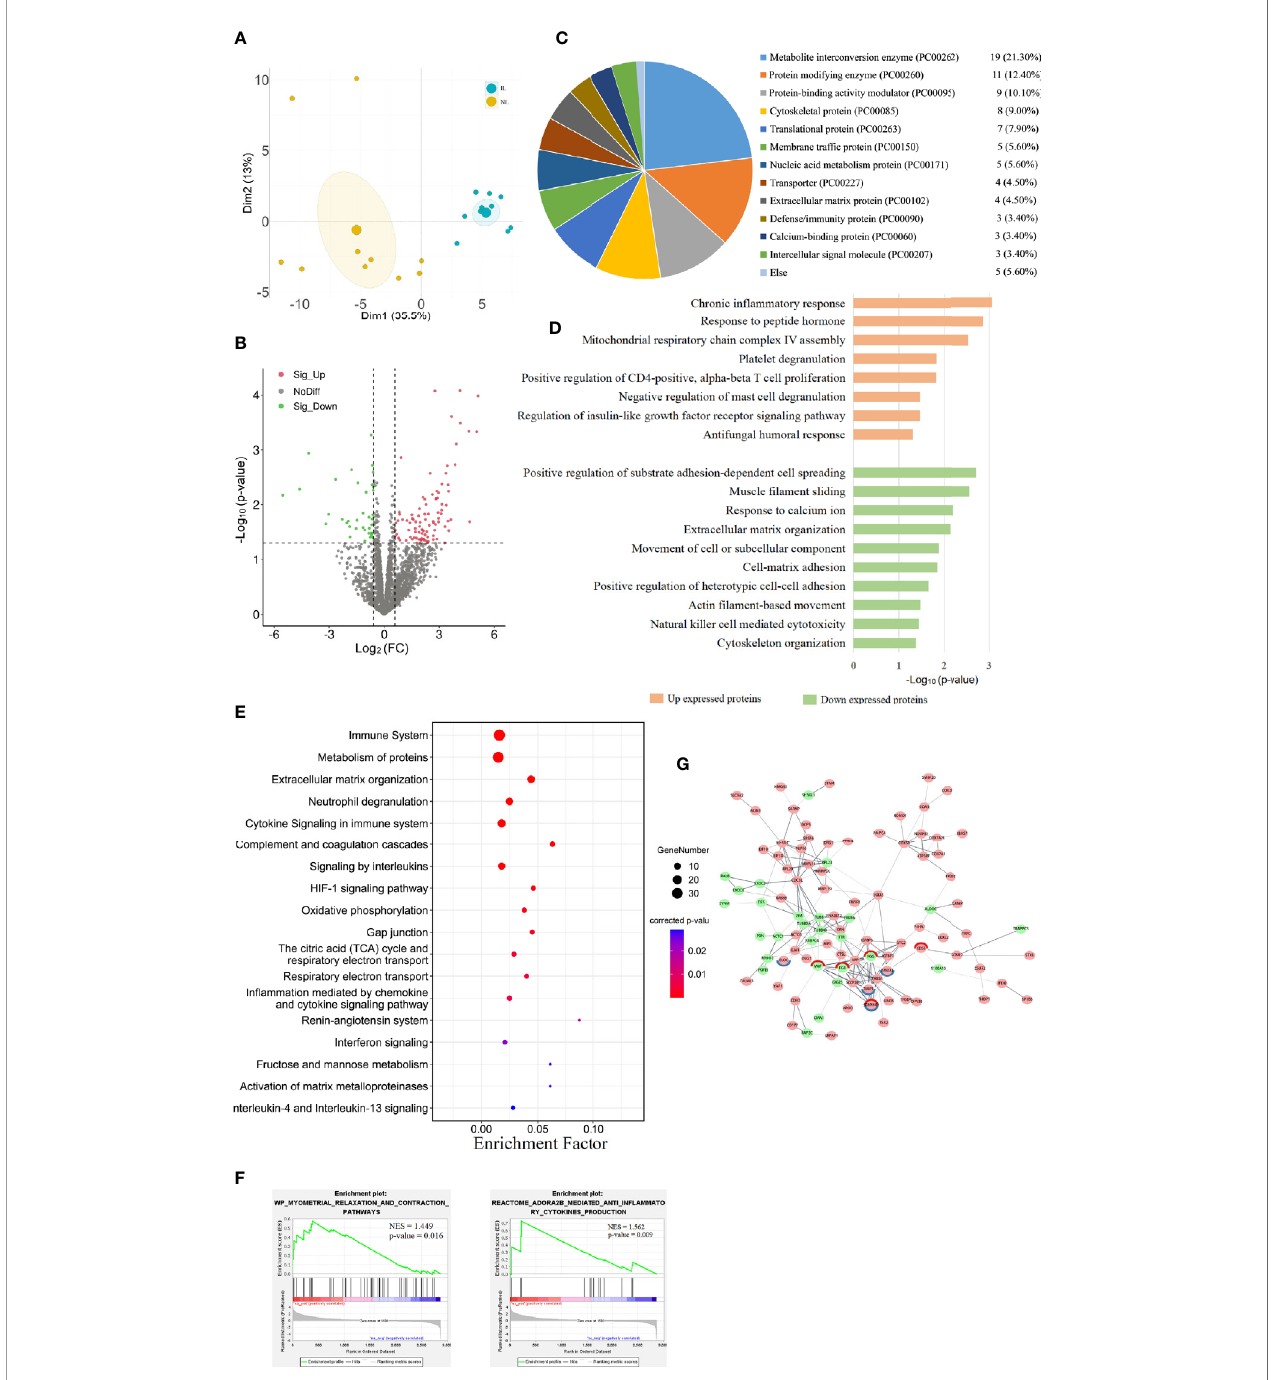
FIGURE 2 | Visualization of the proteomic results between nonlabor and in labor myometrium. (A) PCA plot based on DE proteins. IL samples (blue dots) clustered distinctly from NL (yellow dots). (B) Volcano plot of all protein alteration between NL and IL groups. The horizontal dashed line corresponds to p value < 0.05, and the vertical dashed line corresponds to a 1.5-fold change decrease or increase. Red, green, and black dots represent upregulated, downregulated, and nondifferentially expressed transcripts in the IL group (as compared to the NL group), respectively. Data associated with this fi gure can be found in Supplemental Table 4 . (C) Pie graph for classi fi cation of DE proteins showing the overall percentages of types to the DE proteins. (D) Bar diagram of partial biology progress GO term clusters of DE proteins. (E) Bubble diagram of partial signi fi cantly enriched pathways for DE proteins. (F) GSEA plots of interest sets of myometrial relaxation and contraction pathways and ADORA2B mediated anti-in fl ammatory cytokine production. (G) Protein – protein interactions between DE proteins. Pink circles represent upregulated proteins, green circles represent downregulated proteins, and the circles with red edges and blue edges represent complement and coagulation cascades and HIF-1 signaling pathway key proteins,